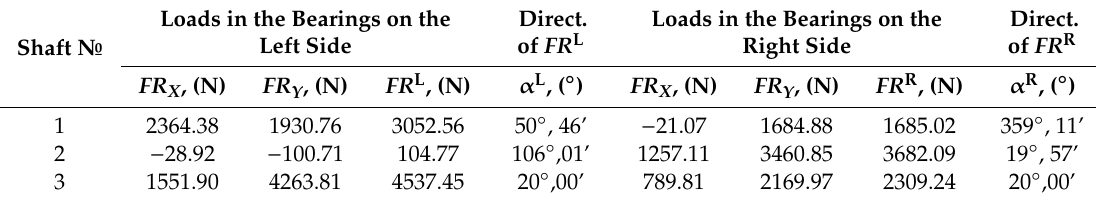
Table 3. Calculated values of the radial loads in